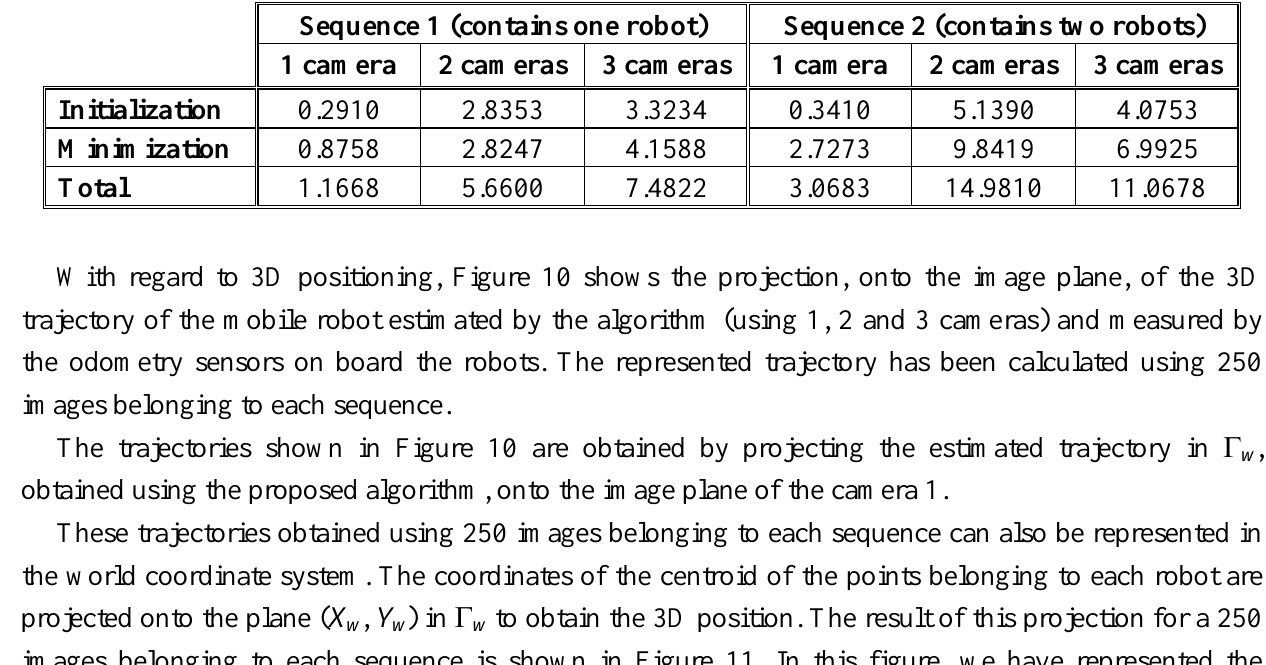
Table 1. Average value of the computation time (in seconds) of each couple of the 500 images belonging to each test sequence for 1, 2 and 3